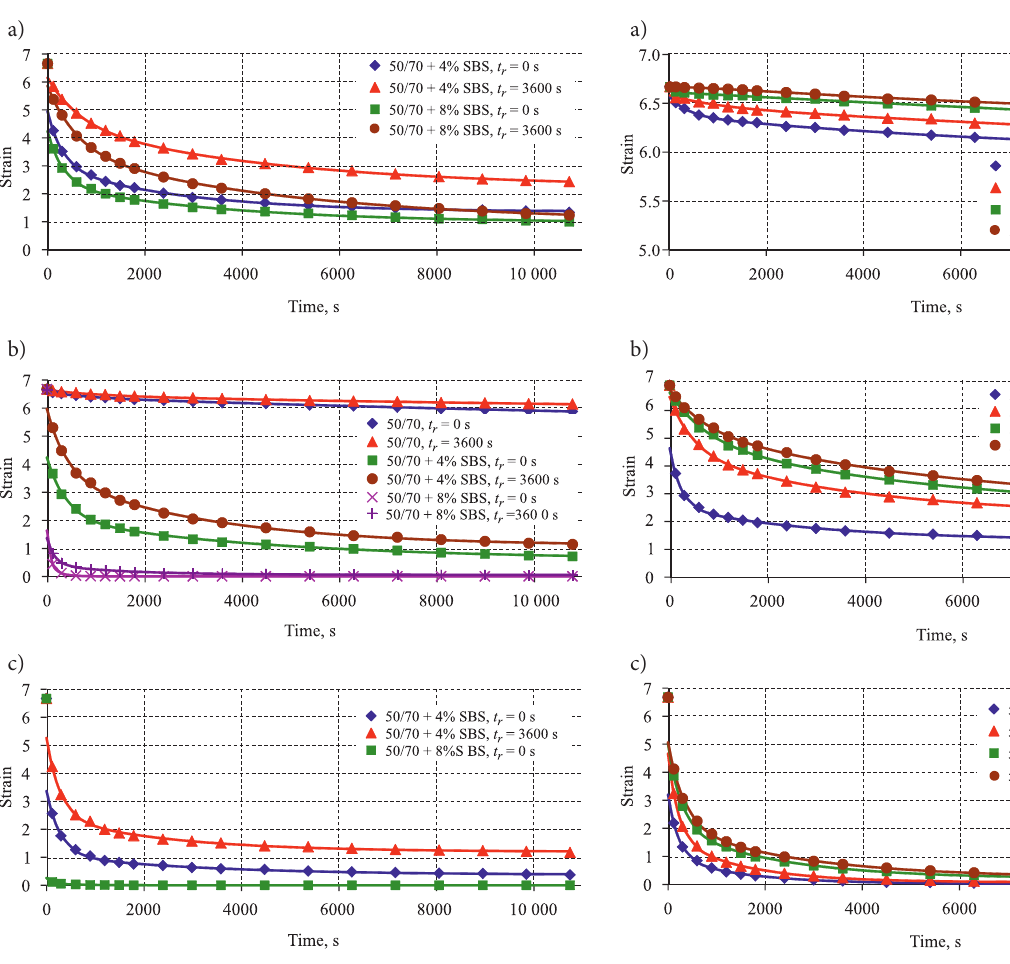
Fig. 8. Inverse creep curves of asphalt binders tested at 15 °C: a – 50/70; b – 50/70 + 4% SBS; c – 50/70 + 8% SBS; the